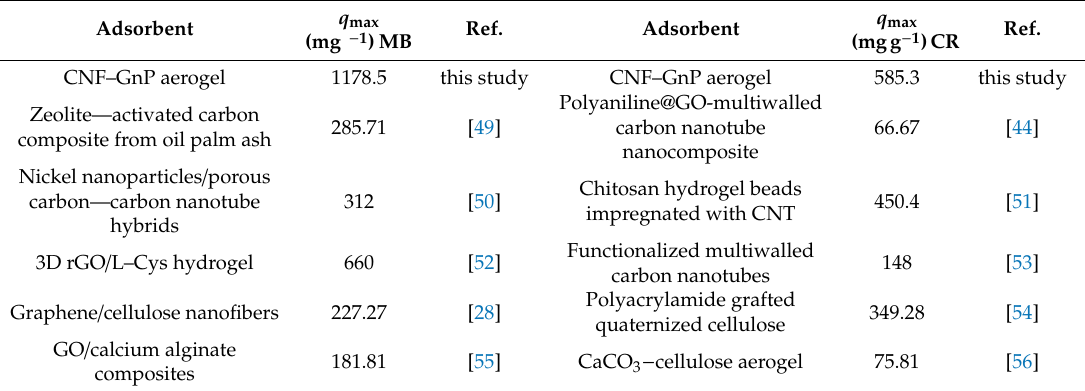
Table 3. Comparison of adsorption capacity of di ff erent